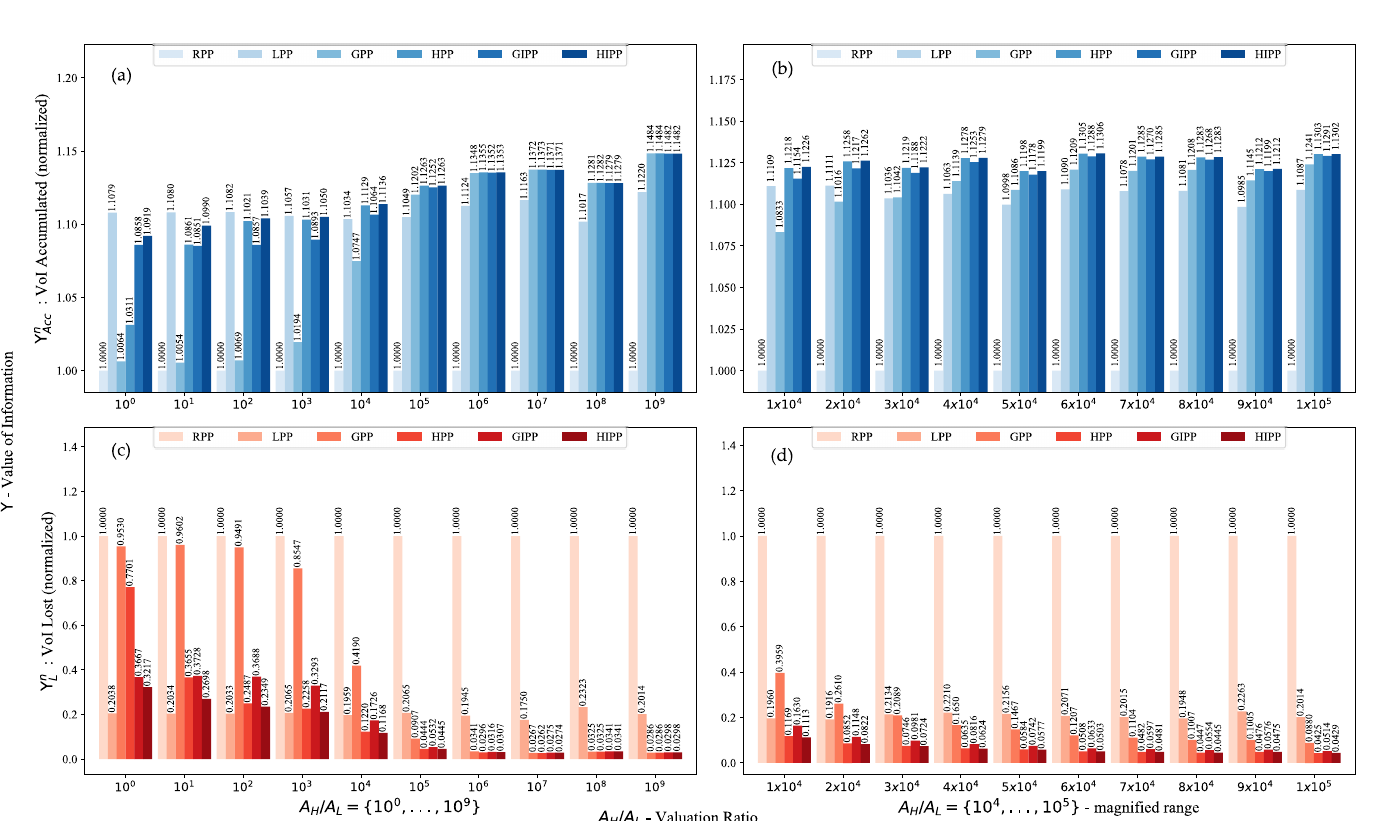
which is charted in the range [ 10 0 :10 9 ] ; ( b ) The top-right graph is Acc which is charted in the range [ 10 0 :10 9 ] ; ( d ) The bottom-right graph is for Υ n L